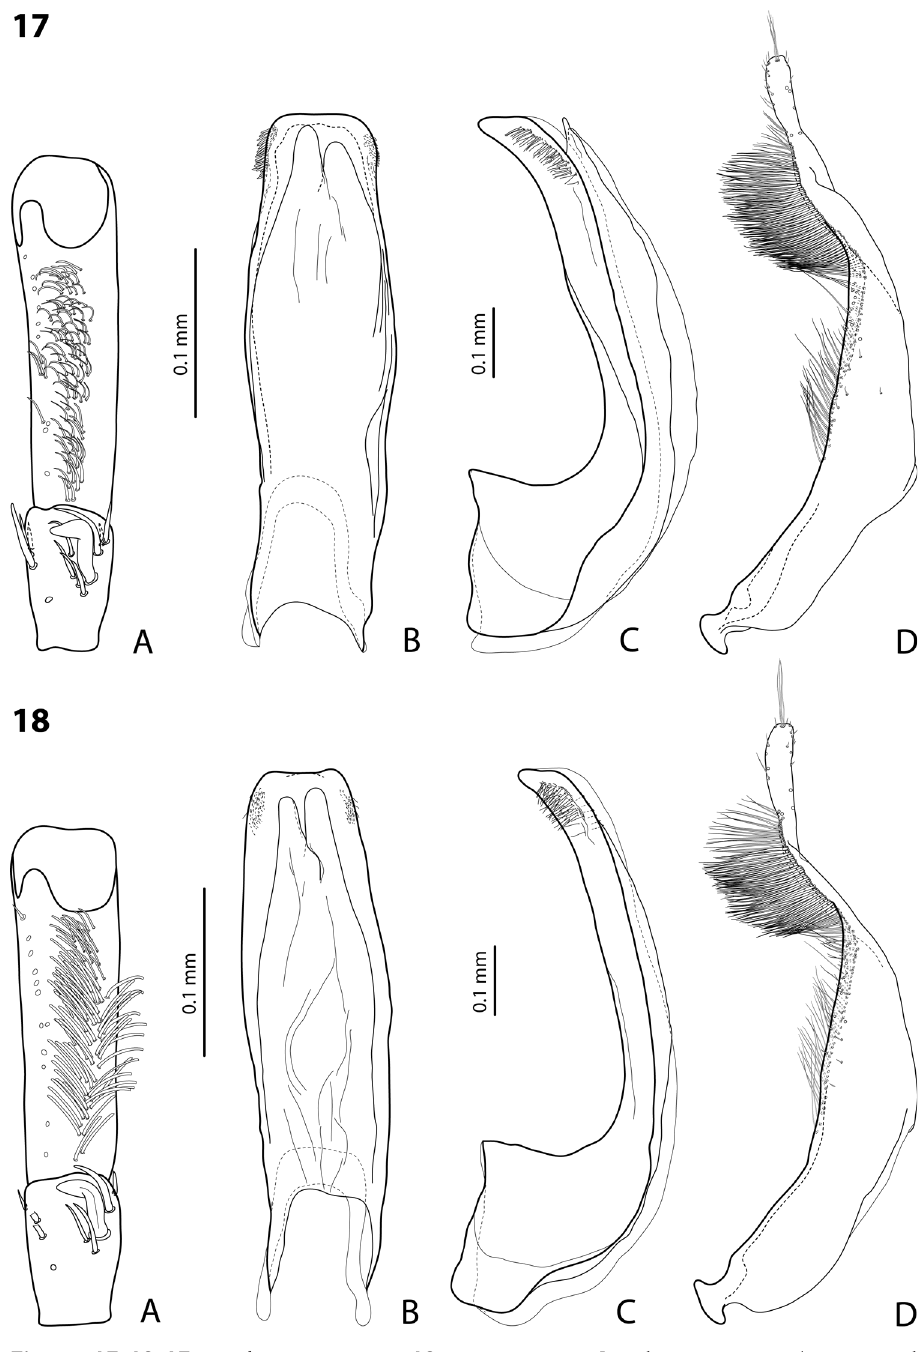
view B median lobe in ventral view C median lobe in lateral view D paramere in external